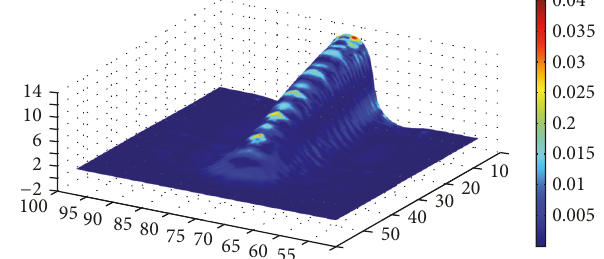
Figure 29: Surface fitting for graphene.